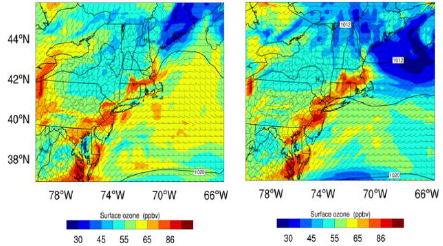
Fig.1 Surface O 3 by WRF/Chem model (shaded colors) and wind (black barb) at 14:00 EST on (left) Aug. 28, (right) Aug. 29, 2018